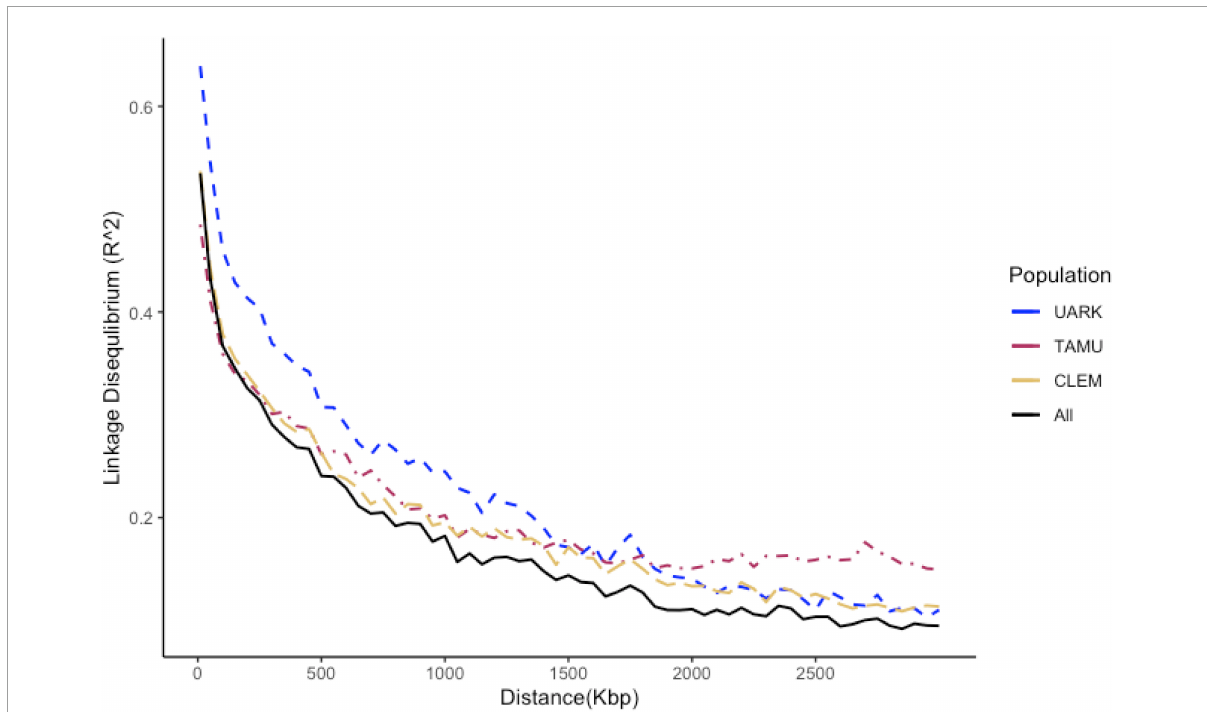
FIGURE1 Decay trend of the linkage disequilibrium (LD) coefficient (R 2 ) with a physical distance by the study population of peach/nectarine individuals assessed for SSC (UARK, University of Arkansas population; TAMU, Texas A&M University population; CLEM, Clemson university population; ALL, all populations combined). The vertical line is drawn at 30 kbp and the horizontal line at 0.42; the average LD across the entire set of